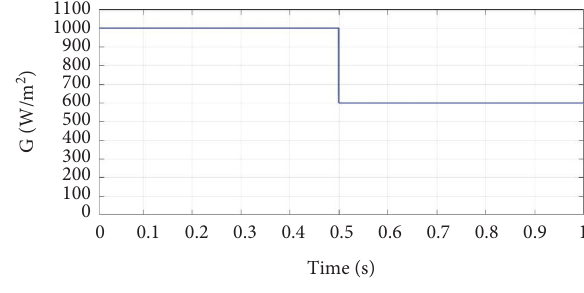
Figure 7: Solar irradiation profle.